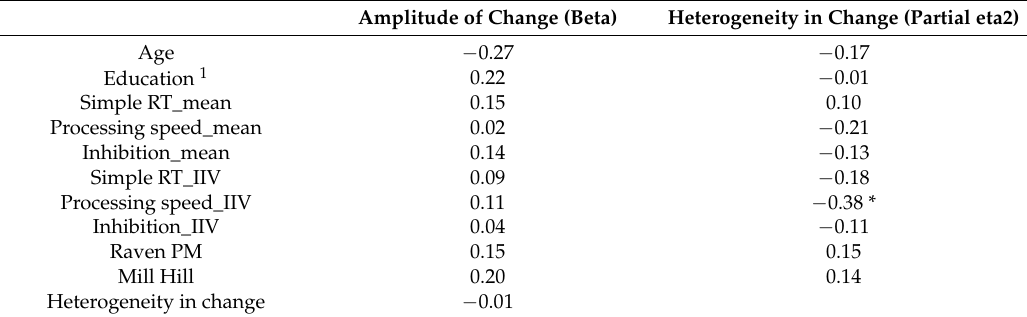
Table 2. Correlations between demographic and cognitive variables and amplitude and heterogeneity of cognitive